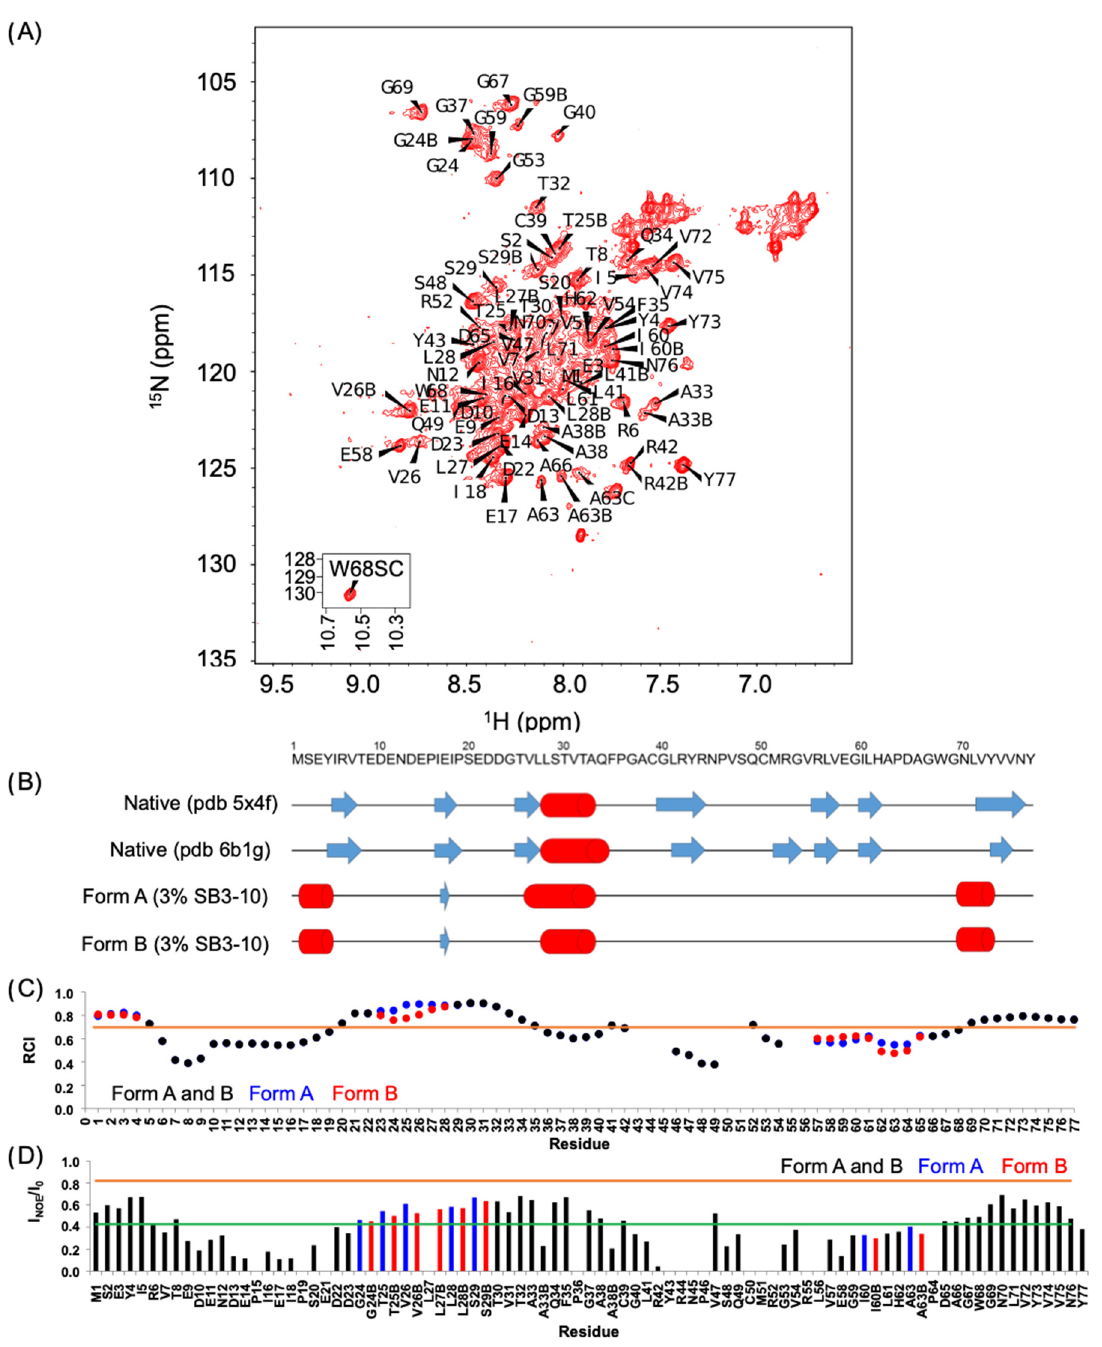
Figure 2. NMR characterization of TDP-43 NTD in 3% SB3-10. ( A ) 1 H- 15 N HSQC spectrum of TDP-43 NTD in 3% ( w/v ) SB3-10 at 25 °C, recorded at 700 MHz. ( B ) Comparison of the secondary structure of native NTD without SB3-10 (pdb id: 5x4f and 6b1g) and of the alternative conformation in 3% SB3-10 reporting the consensus analysis of Talos+, CSI and SSP for forms ( A ) and ( B ). Blue arrows indicate extended structures ( β -strands) and red cylinders stand for α -helices. ( C ) Random coil index (RCI) values as predicted by Talos+. The black, blue and red bars correspond to both forms, form ( A ) and form ( B ), respectively. RCI values correspond to order parameters (S 2 ). Residues with S 2 ≤ 0.7 (orange line) are considered too flexible to produce reliable torsion angles [26]. ( D ) 15 N{ 1 H} NOE ratios at 25 °C. Colour codes as in panel ( C ). The green and orange lines indicate the average NOE value and the NOE value expected for a rigid structure (0.82) [30], respectively.